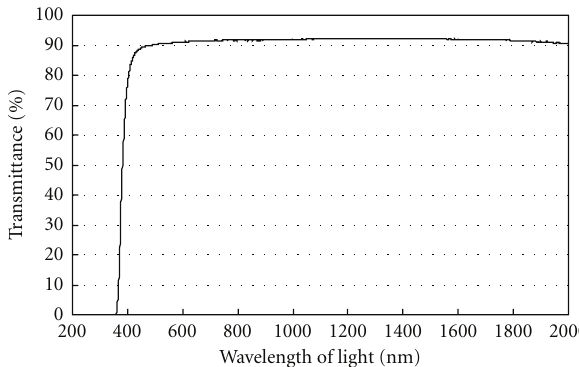
Figure 3: Light transmittance data of the coloured glass filter.